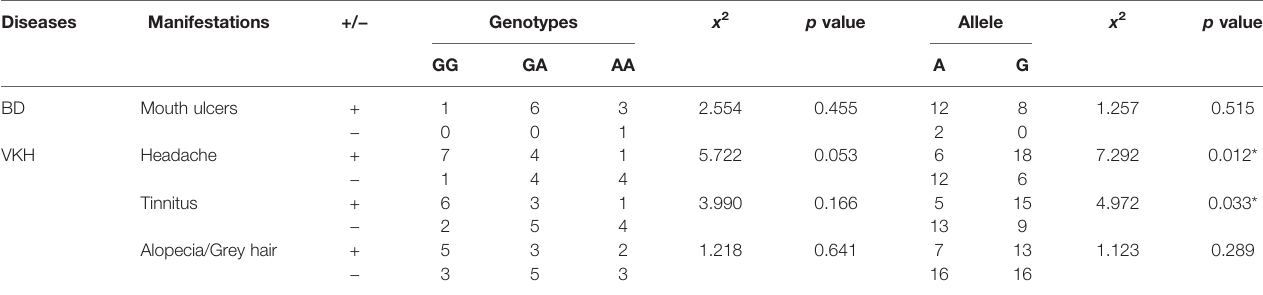
TABLE 6 | Associations of EBI3 (rs4740) with clinical manifestations in BD or VKH patients. Diseases